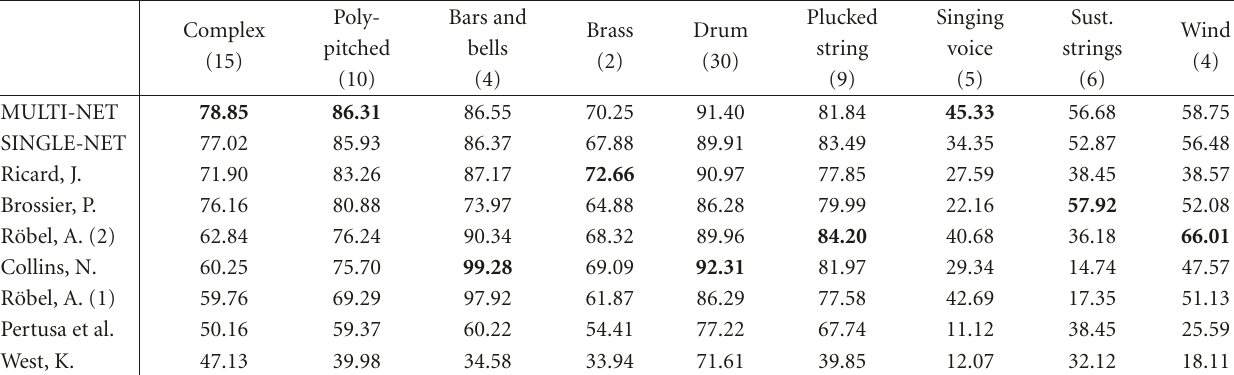
Table 7: F-measure percentages for all nine classes from the MIREX 2005 audio onset detection contest. Best performance for each class is shown in bold. The number of pieces for each class is shown in